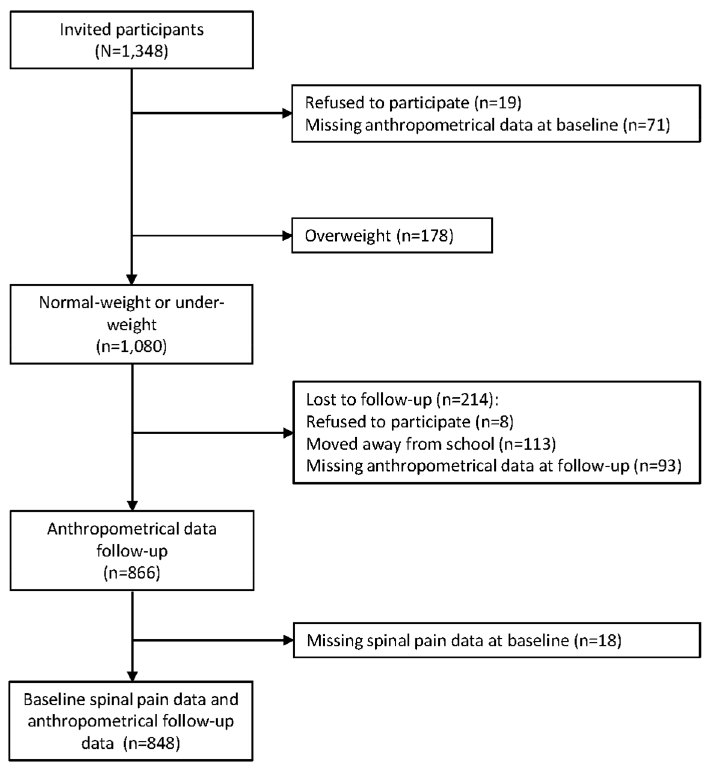
Figure 2. Flowchart of participation.